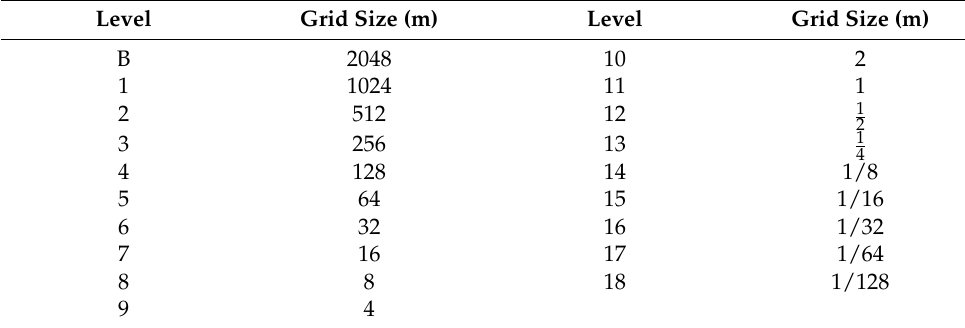
Table 1. Indoor space section hierarchy